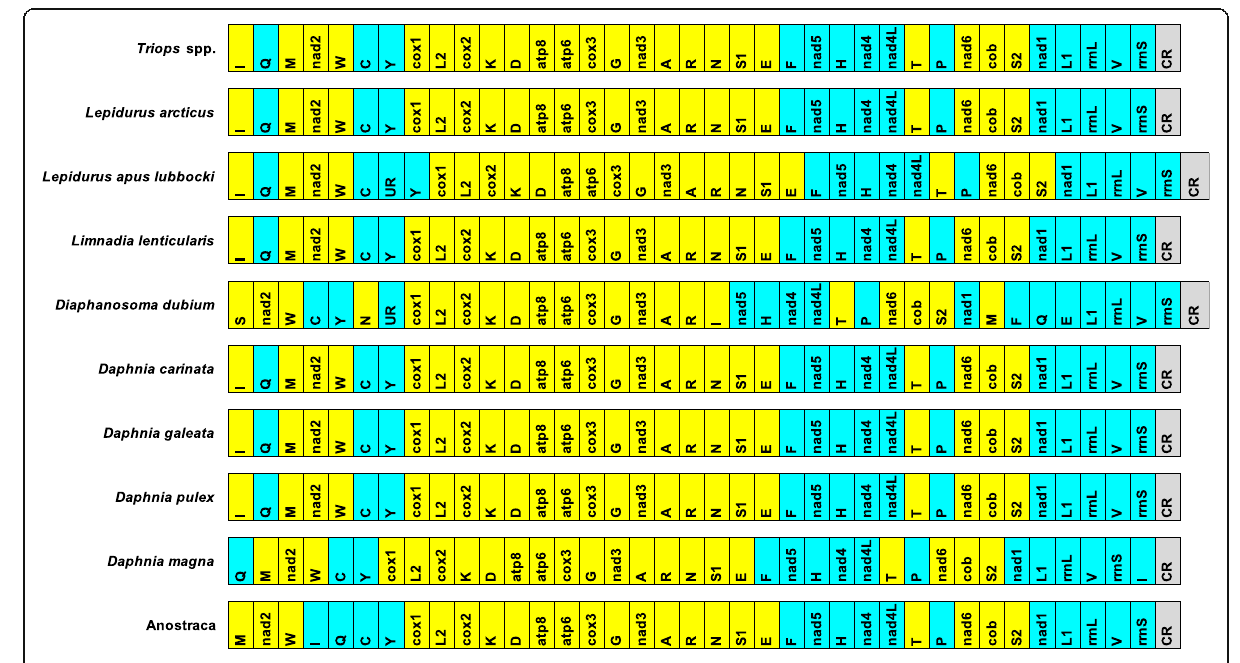
Fig. 3 Gene arrangement in analyzed branchiopod mitogenomes. The yellow and cyan colours indicate genes on the H and L strand, respectively